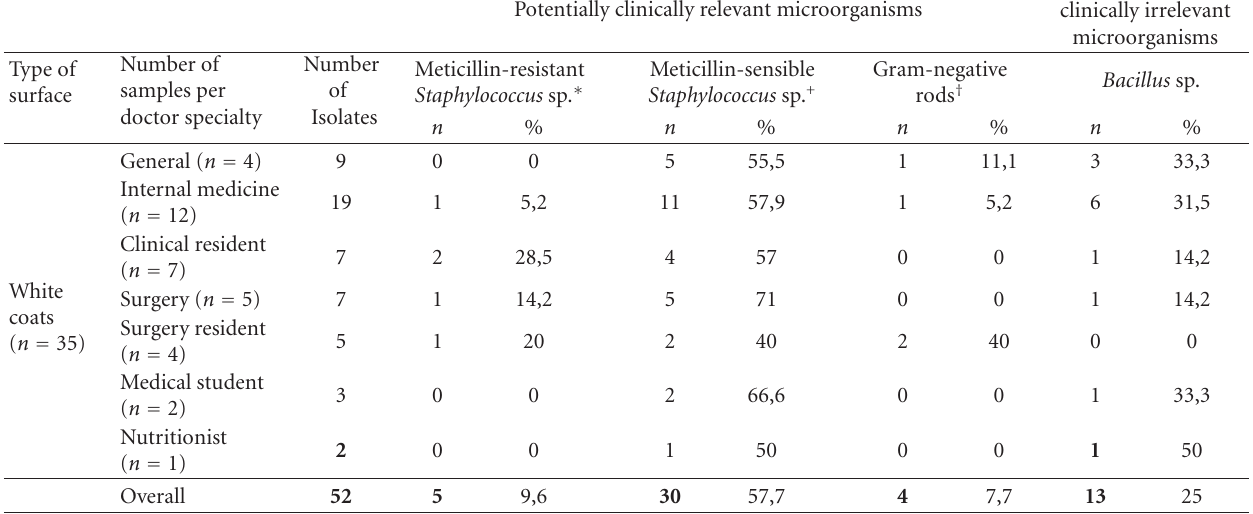
Table 4: Distribution of bacterial isolates from white coats.